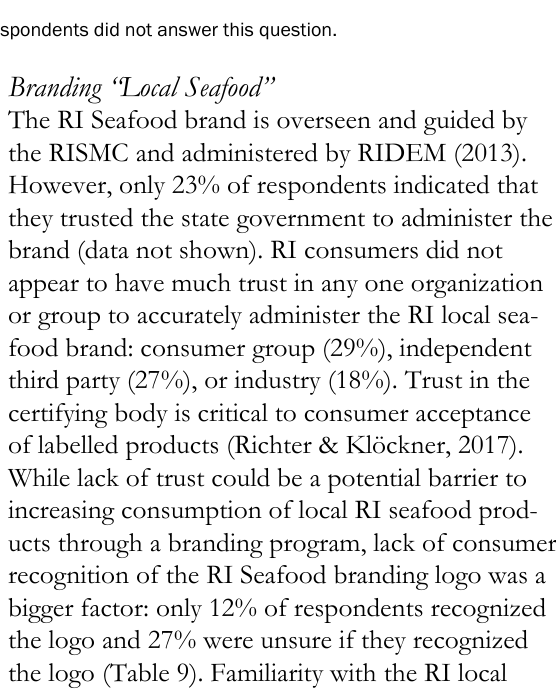
Caught by RI licensed fishers but landed in another state port and trucked to RI Landed in a Northeast (Virginia to Maine) port Sold in Rhode Island, regardless of where or by whom the fish was caught Other Respondents checked all that applied.